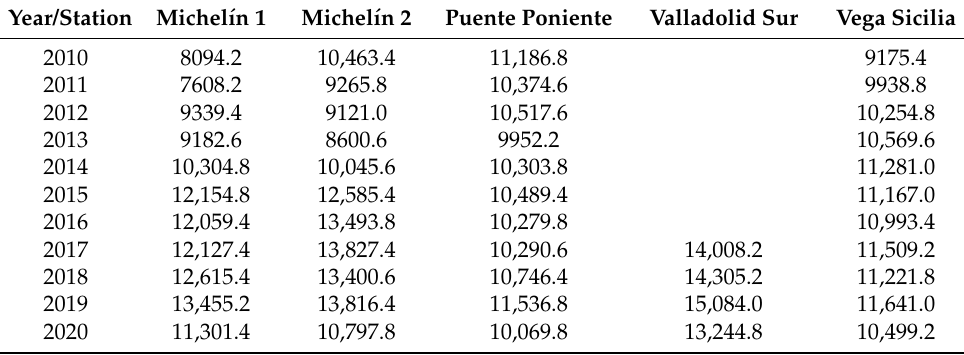
Table 4. Limit of vegetation protection (AOT40) on the five-year average ( µ g m − 3 × h).